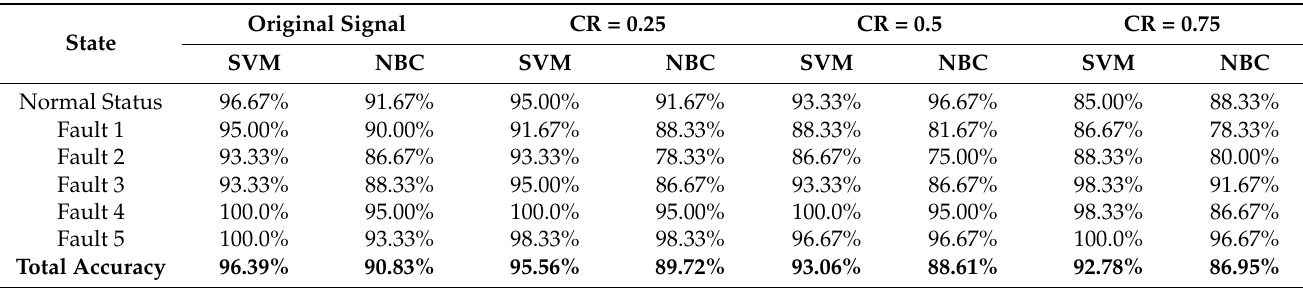
Table 2. Comparative analysis of fault classification under different compression